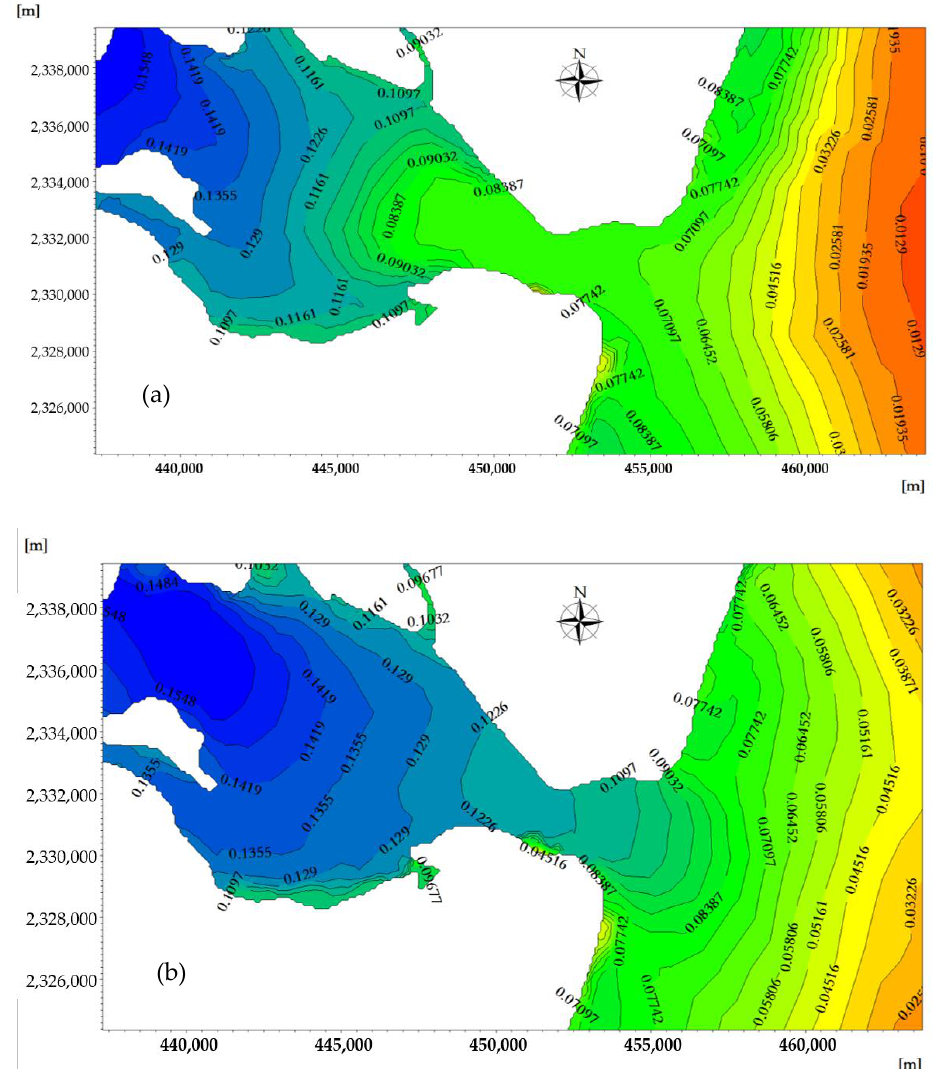
Figure 14. The spatiotemporal distribution of the phosphorus concentration near the tidal inlet at the moment when the velocity of the flood tide ( a ) and ebb tide ( b ) reaches its maximum (mg/L).